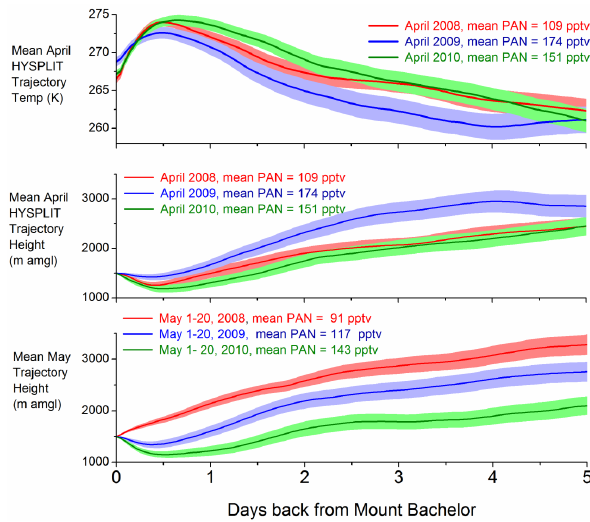
Figure 4 : Vertical distribution of air mass transport to MBO during April and May 2008 to 966 Fig. 4. Vertical distribution of air mass transport to MBO during 2010. These maps are created from 10-day HYSPLIT backward trajectories initialized from 967 April and May 2008 to 2010. These maps are created from 10-day MBO each hour. Top: Mean trajectory temperature for April (line) with 95% confidence 968 HYSPLIT backward trajectories initialized from MBO each hour. Top: mean trajectory temperature for April (line) with 95% confi- interval (shading). Middle: Mean trajectory height for April (line) with 95% confidence interval 969 dence interval (shading). Middle: mean trajectory height for April (shading). Bottom: As above, but for May 1 – 20. 970 (line) with 95% confidence interval (shading). Bottom: as above, but for 1–20 May